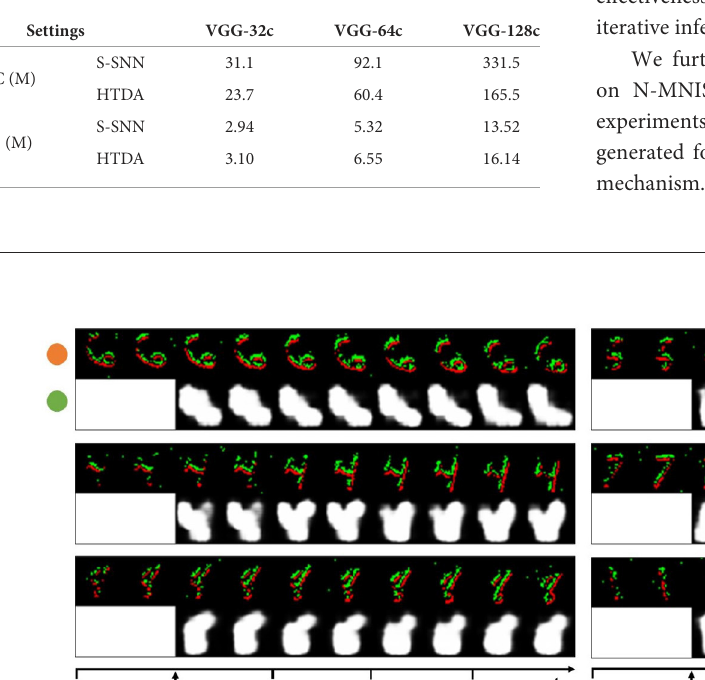
TABLE 2 Comparison of computing operations and the number of parameters of different models.